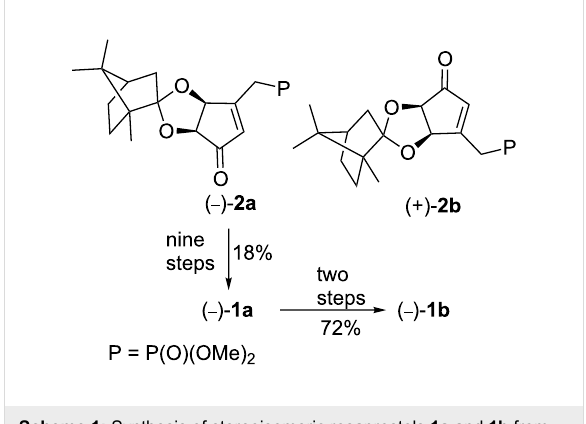
and as part of our research program on the synthesis and study of the stereostructure–bioactivity relationship in biologically active compounds [18,19], including selected prostanoids [20- 22], we decided to synthesize all four rosaprostol stereoisomers 1a–d in enantiomerically pure form (Figure 2). The two rosaprostol stereoisomers 1c and 1d have an absolute configura- tion at C-2 of the cyclopentane ring opposite to that in natural prostaglandins of the A and J series. Therefore these com- pounds are expected to exhibit an increased biological stability as compared with 1a and 1b , and to be more efficacious in the treatment of gastric ulcers [23].